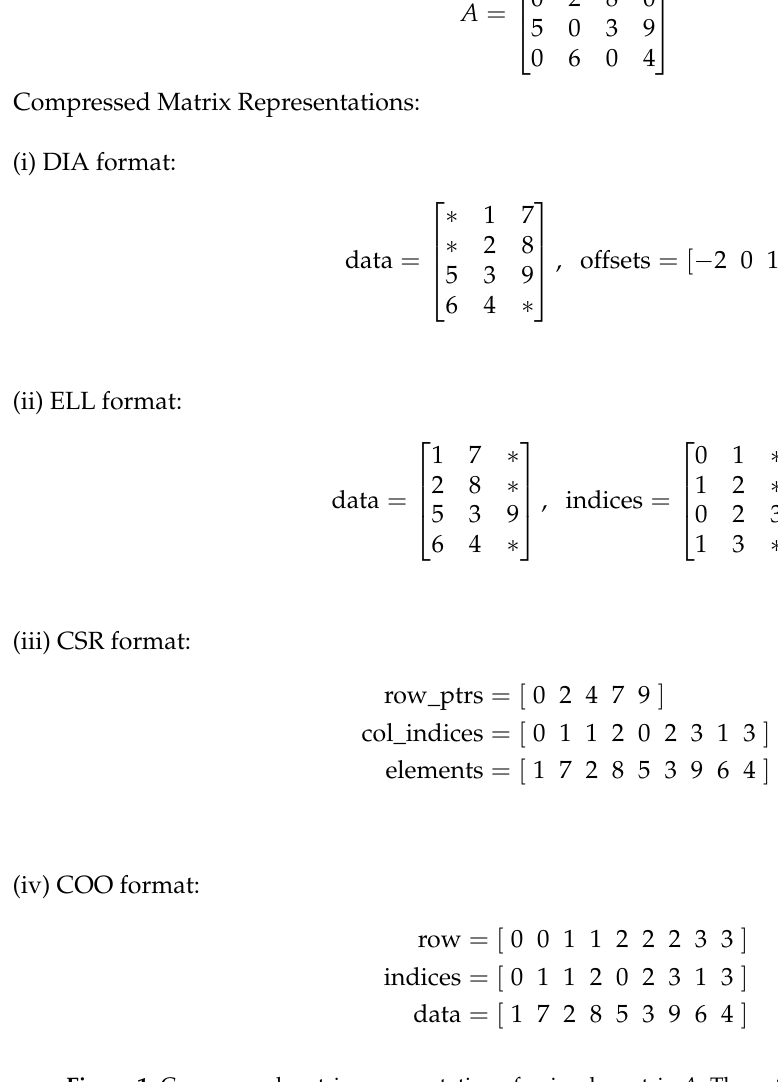
Figure 1. Compressed matrix representation of a simple matrix A . The entries marked by ∗ are padding entries ([64], Figure